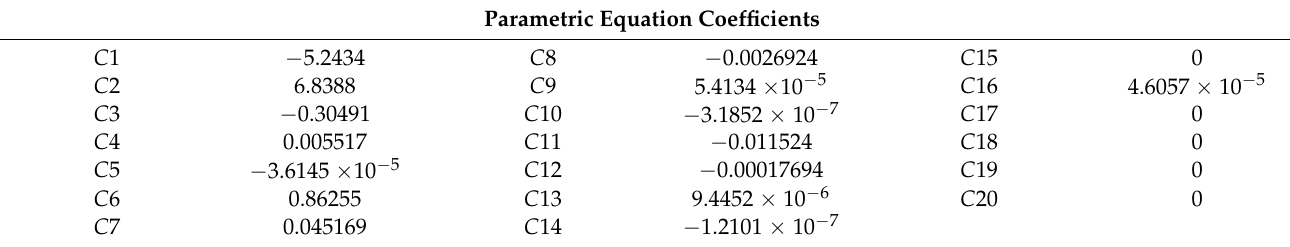
Table A1. Terms of the controller, motor, and reduction gears (CMRGs) efficiency parametric